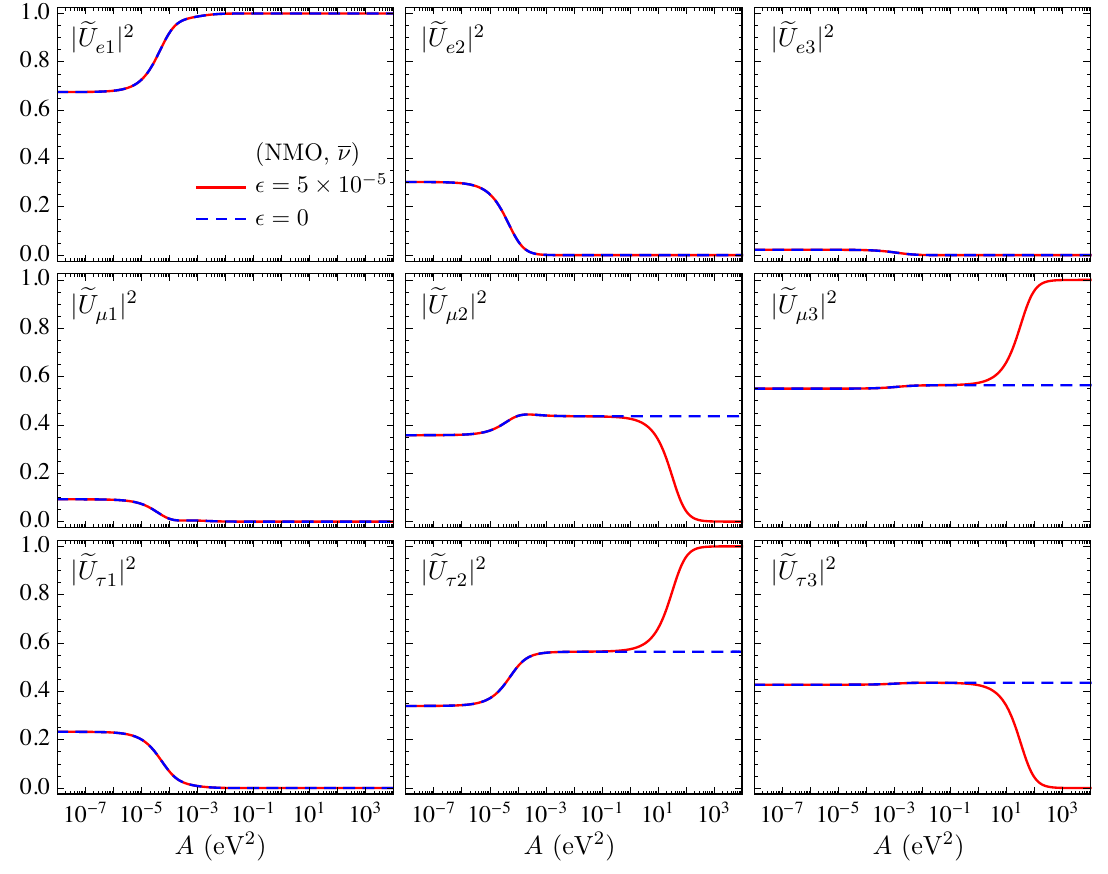
Figure 5 . In the standard three-(cid:13)avor mixing scheme, the illustration of how (cid:22); (cid:28) and i = 1 ; 2 ; 3) evolve with the matter e(cid:11)ect parameter A in the case (NMO ; (cid:23) ) with or without radiative corrections, where the best-(cid:12)t values of ( (cid:18)